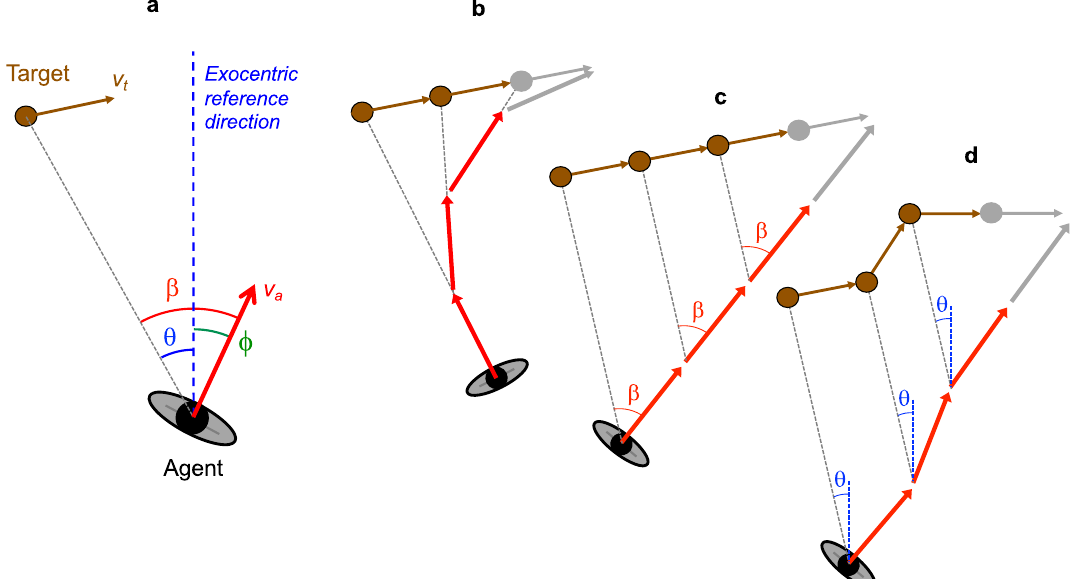
Figure 1. ( a ) Definition of variables in a plan view of an agent moving through an environment containing a target moving in the same plane. Instantaneous velocity vectors are represented by arrows (red for agent, brown for target). Agent heading ϕ and target bearing θ are defined with respect to an exocentric reference direction (dashed blue line). Target-heading angle β is defined by the eccentricity of the target with respect to the agent’s direction of locomotion so that β = ϕ − θ. ( b , c , and d ) Typical timestep-based representations of interception heuristics: ( b ) Zero Target-Heading Angle (ZTHA) or classical pursuit, ( c ) Constant Target-Heading Angle (CTHA) or classical interception, and ( d ) Constant Bearing Angle (CBA). Note that for an agent following a straight-line trajectory, as depicted in ( c ), not only THA β is constant but BA θ (not depicted) is also constant. The straight-line steady-state behaviour therefore does not allow disambiguating β-based and θ-based influences on behaviour. With all three examples being based on instantaneous enactment, at each time step, of a